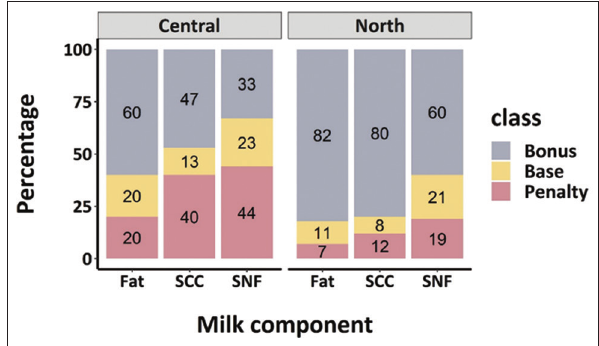
Figure-2: Percentage of bulk tank milk (BTM) in different payment classes for various milk components, including fat, somatic cell count, and solids not fat. BTM samples were collected from the central and northern region of Thailand. The same pricing system was used for both regions.